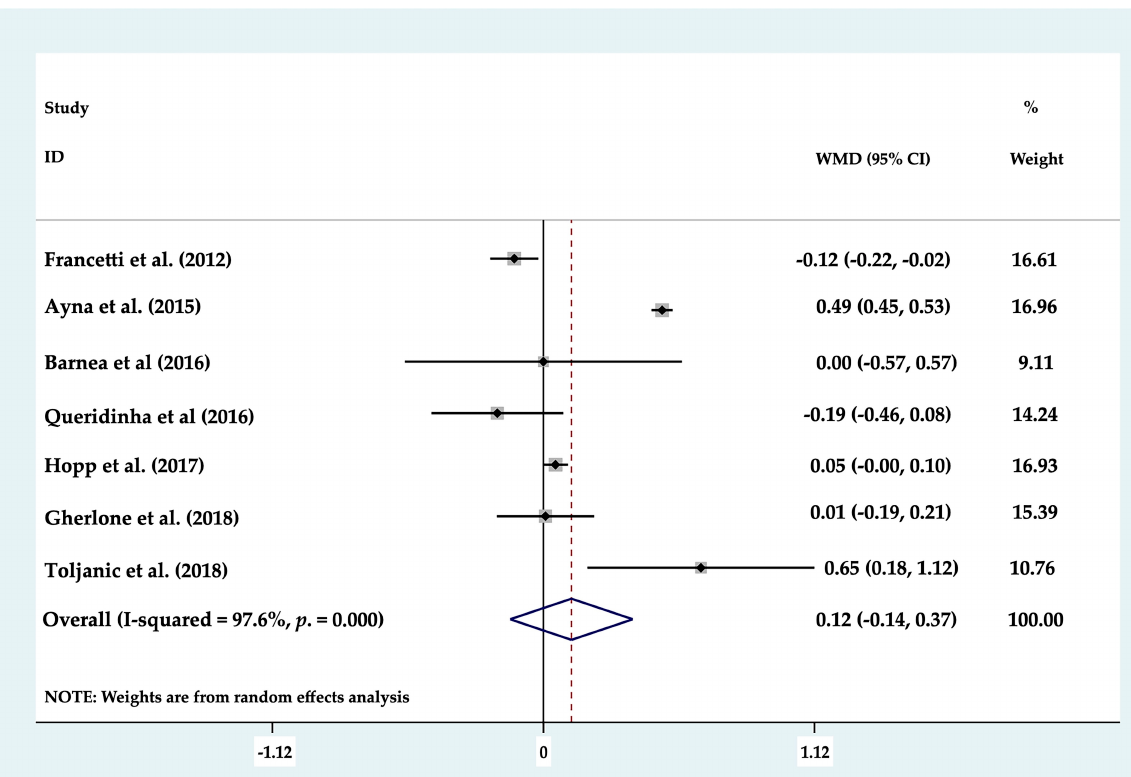
0.05) were found. ≥